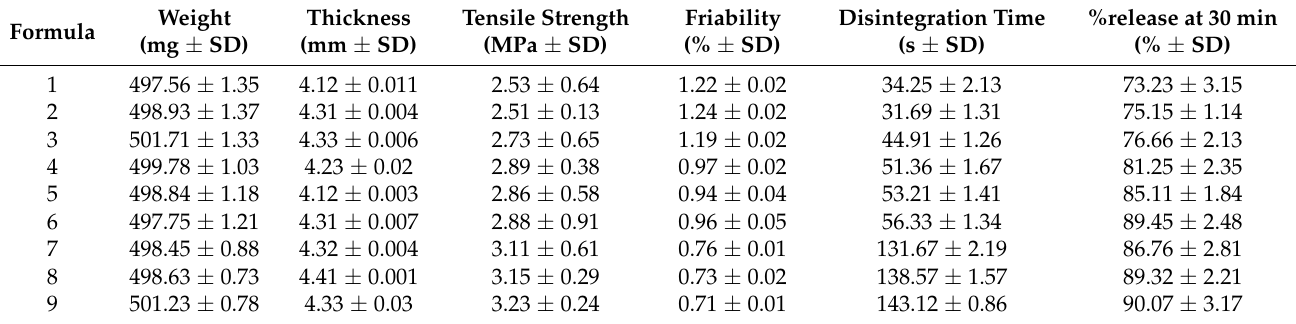
Table 7. Measured response results of prepared tablets (mean ± SD).